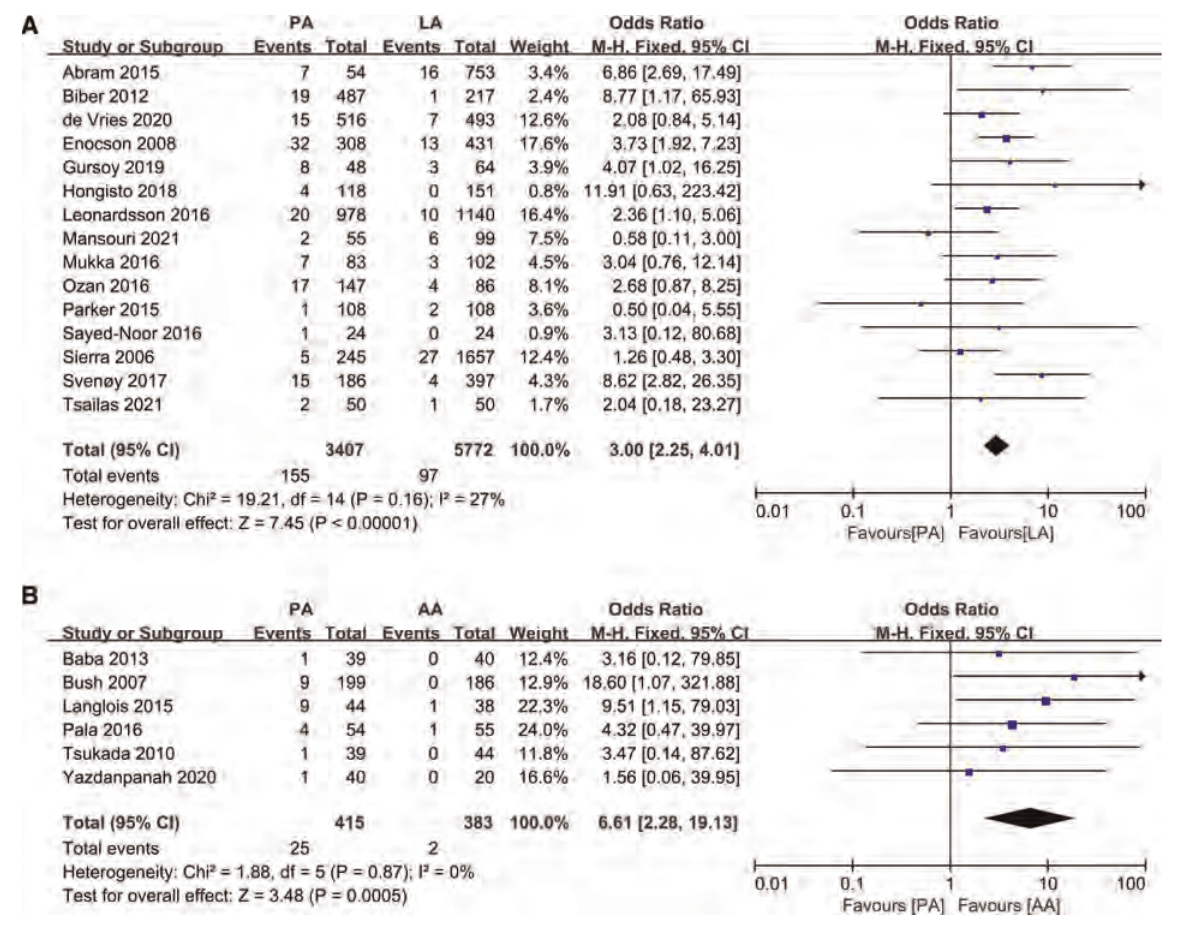
FIGURE 6 Forest plot comparison of dislocation. ( A ) Anterior approach and lateral approach, ( B ) Posterior approach and anterior